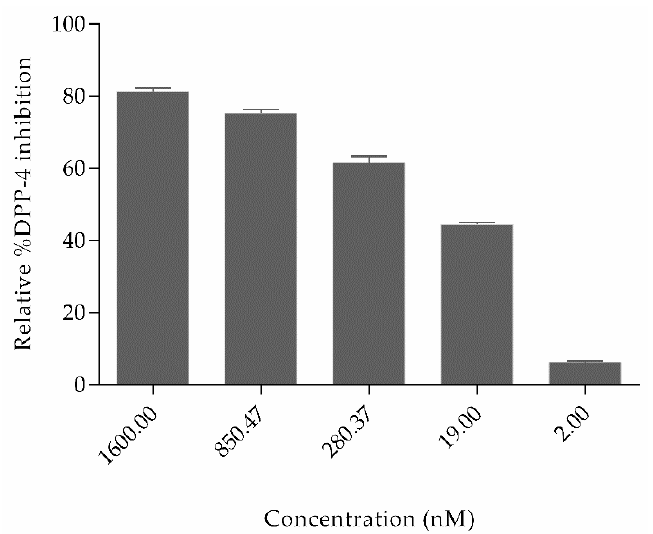
Figure 5. Relative percent inhibition of the dipeptidyl peptidase-4 (DPP4) enzyme by natural cyclic peptide oxytocin at five different concentrations. The two ‐ tailed unpaired t ‐ test was utilized to calculate the significant difference among different concentrations. Data represent mean ± S.D.